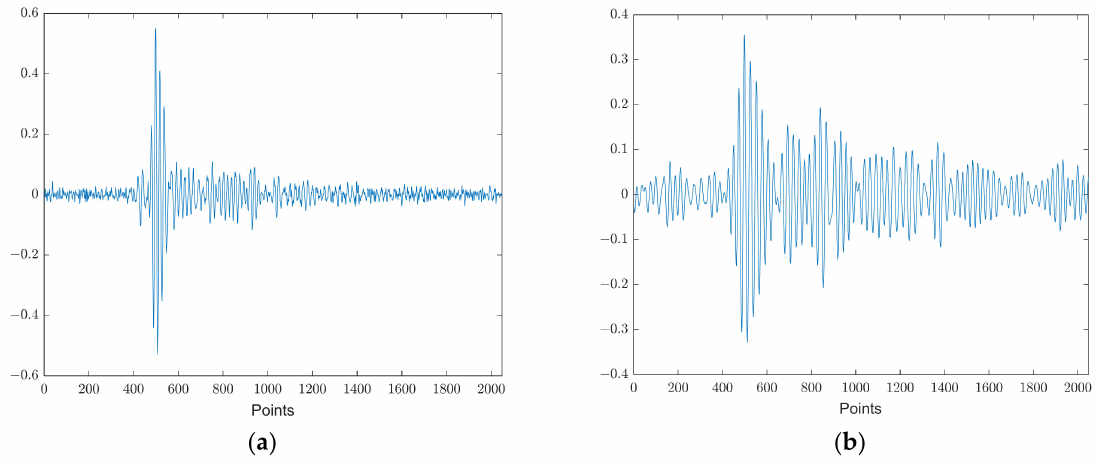
Figure 1. Flaw A scan signal example for database construction: ( a ) crack; ( b )